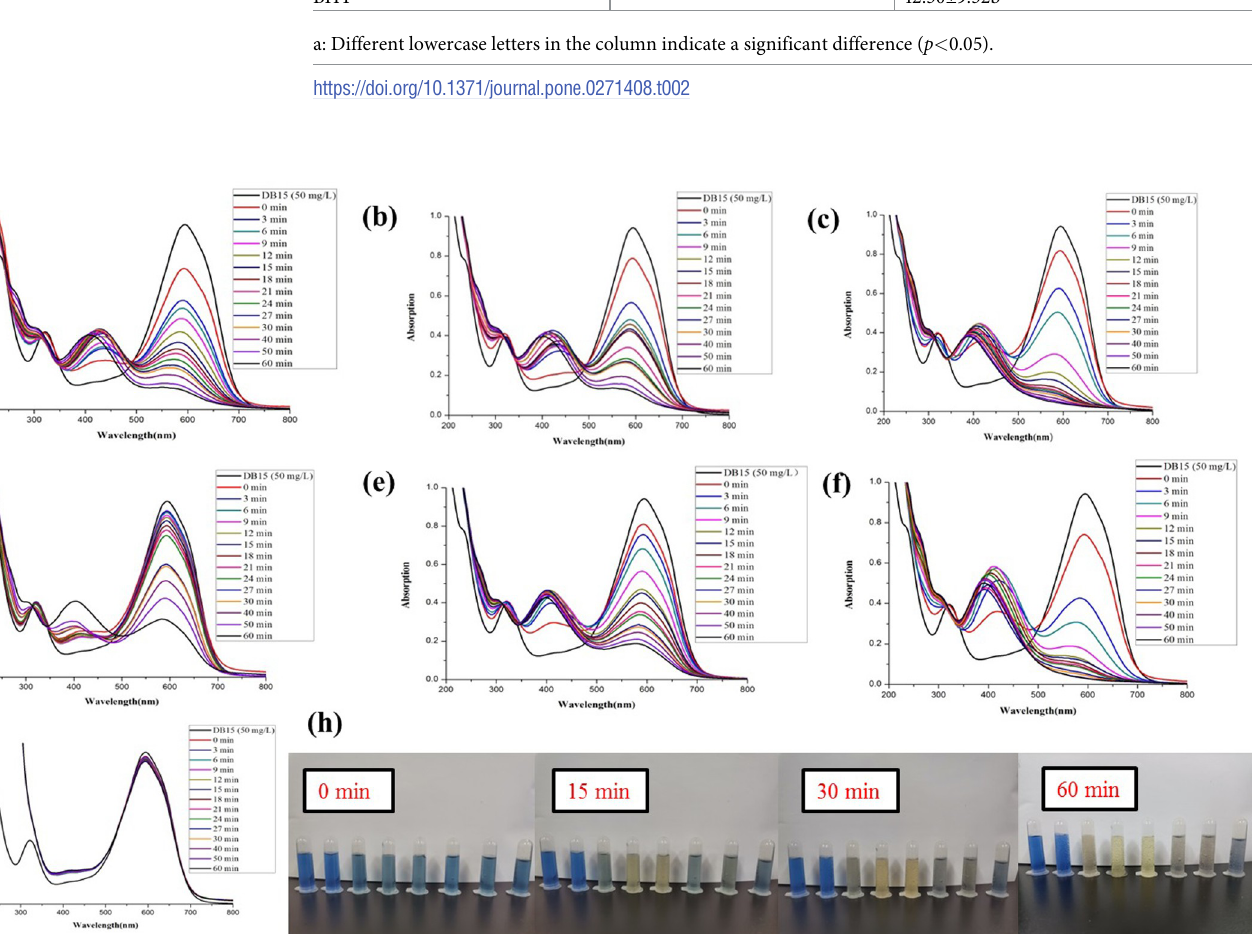
PLOS ONE | https://doi.org/10.1371/journal.pone.0271408 August 25,